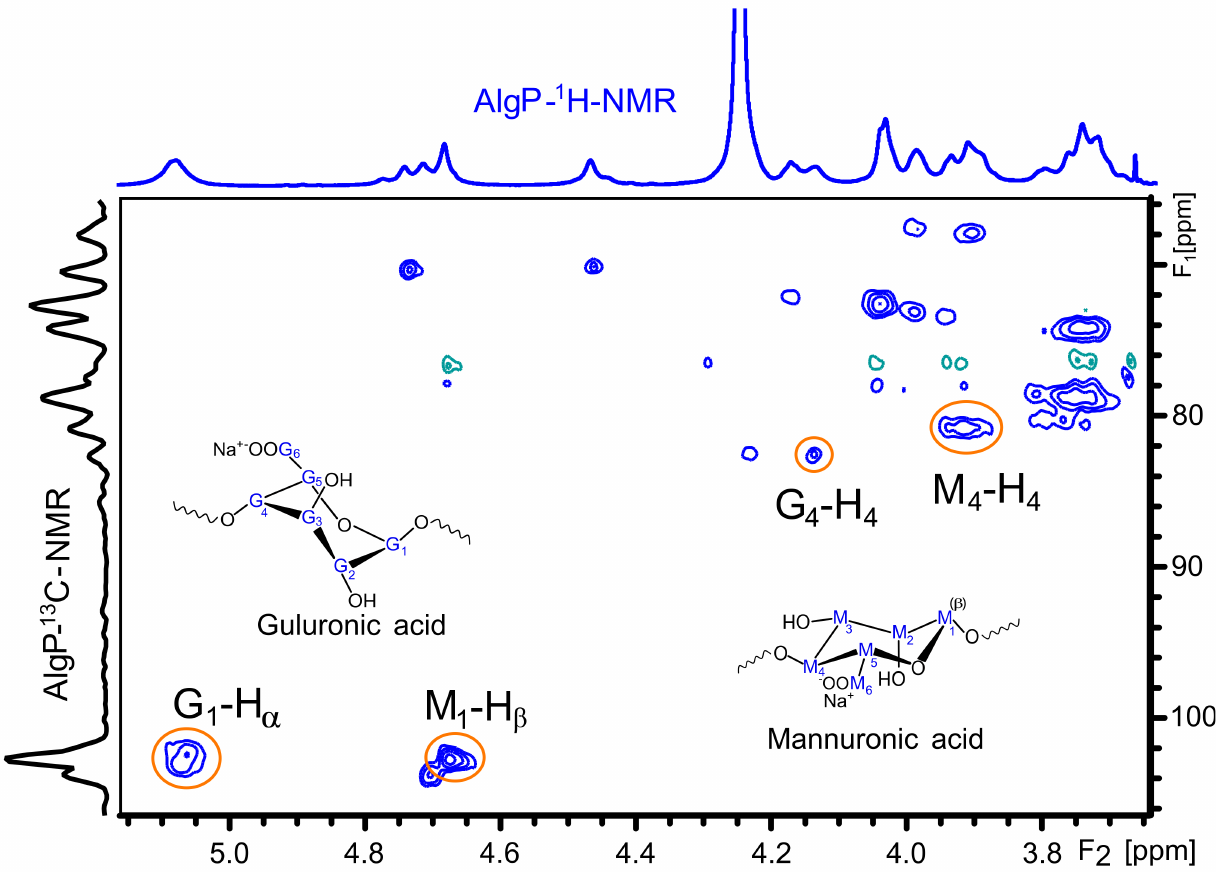
Figure 5. HSQC spectrum of purified alginate (AlgP). Table 1. Assignment of the chemical shifts of AlgP 1 H